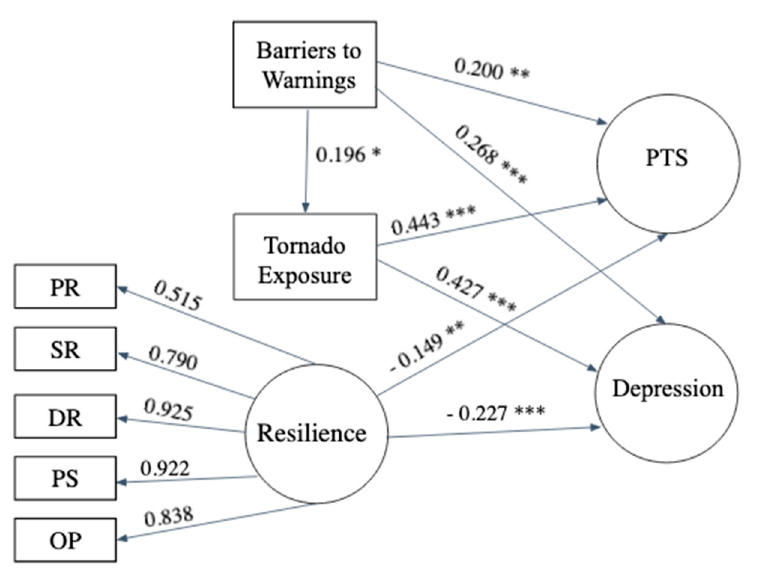
Figure 1. Diagram of Structural Model. Note: Model Fit statistics: Model Fit: χ 2(146) = 206.495, p < 0.01, CFI = 0.975, TLI = 0.970, RMSEA = 0.048, SRMR = 0.051. PR = Physical Resources, SR = Social Resources, DR = Distress Regulation, PS = Problem Solving, OP = Optimism, PTS = Posttraumatic stress symptoms. * p < 0.05, ** p < 0.01, *** p < 0.001.